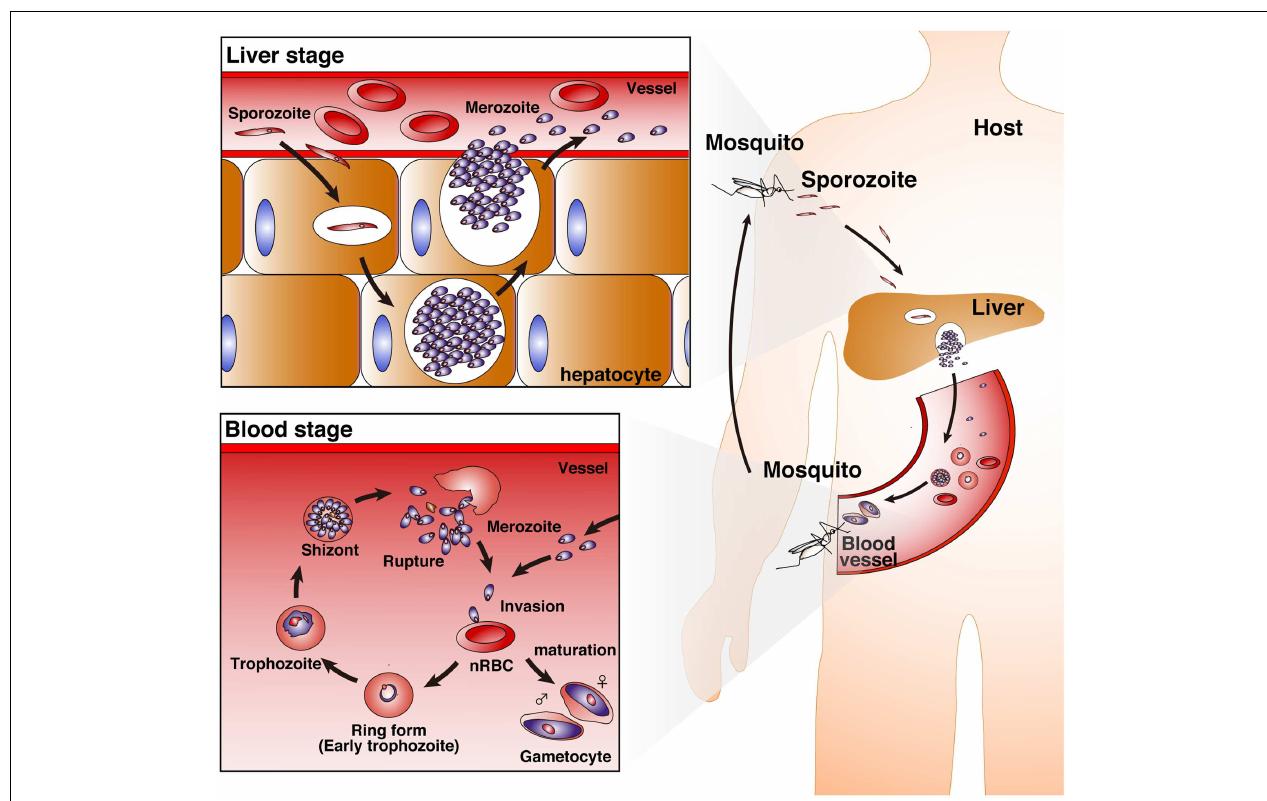
FIGURE 1 | Life cycle of Plasmodium parasites . A bite from a Plasmodium -infected Anopheles mosquito inoculates human hosts with sporozoites in the dermis of skin.The sporozoites move into the bloodstream, and parasitize hepatocytes. Invaded sporozoites develop into merozoites with replication (liver-stage).Then, merozoites are released from